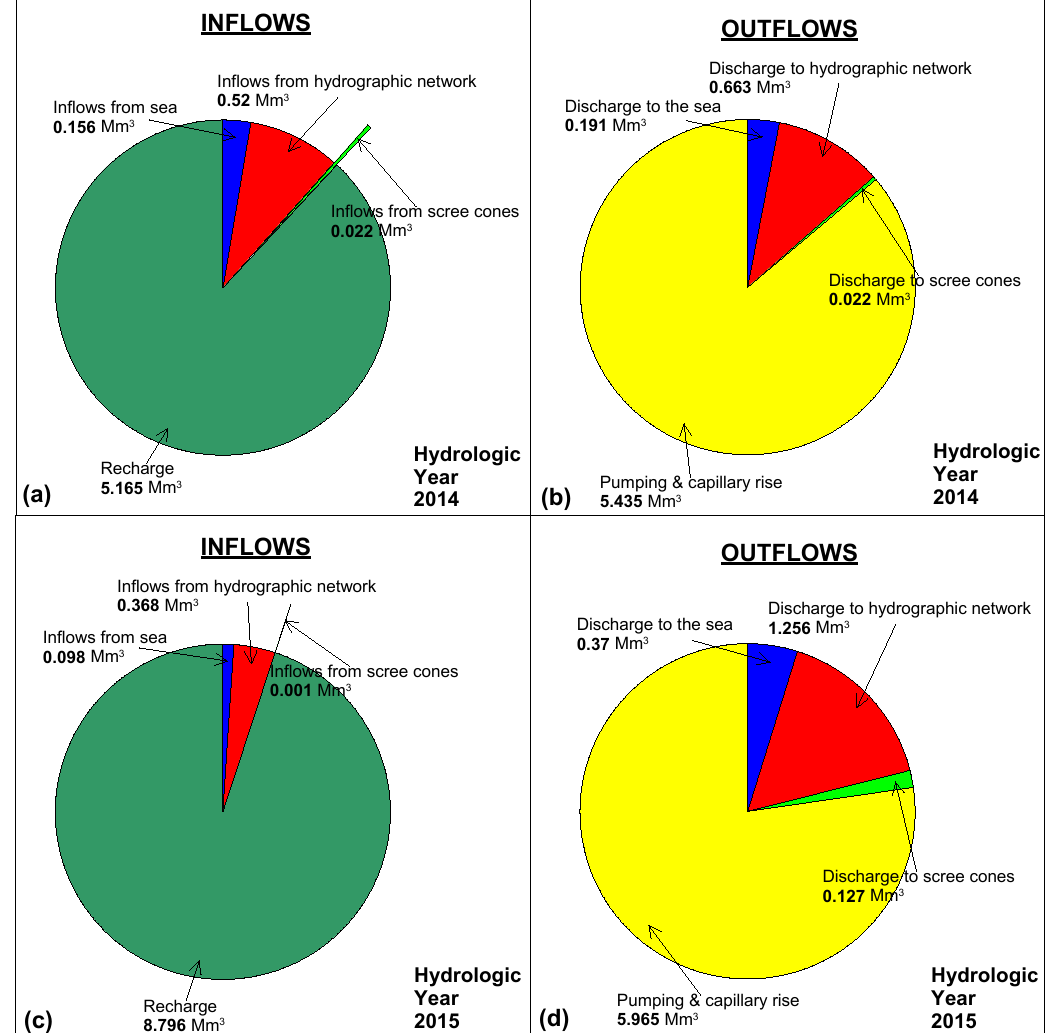
Figure 5. Graphical representation of groundwater balance of PRDP phreatic aquifer for hydrological years 2014 ( a , b ) and 2015 ( c , d ). Change in groundwater storage is not included.